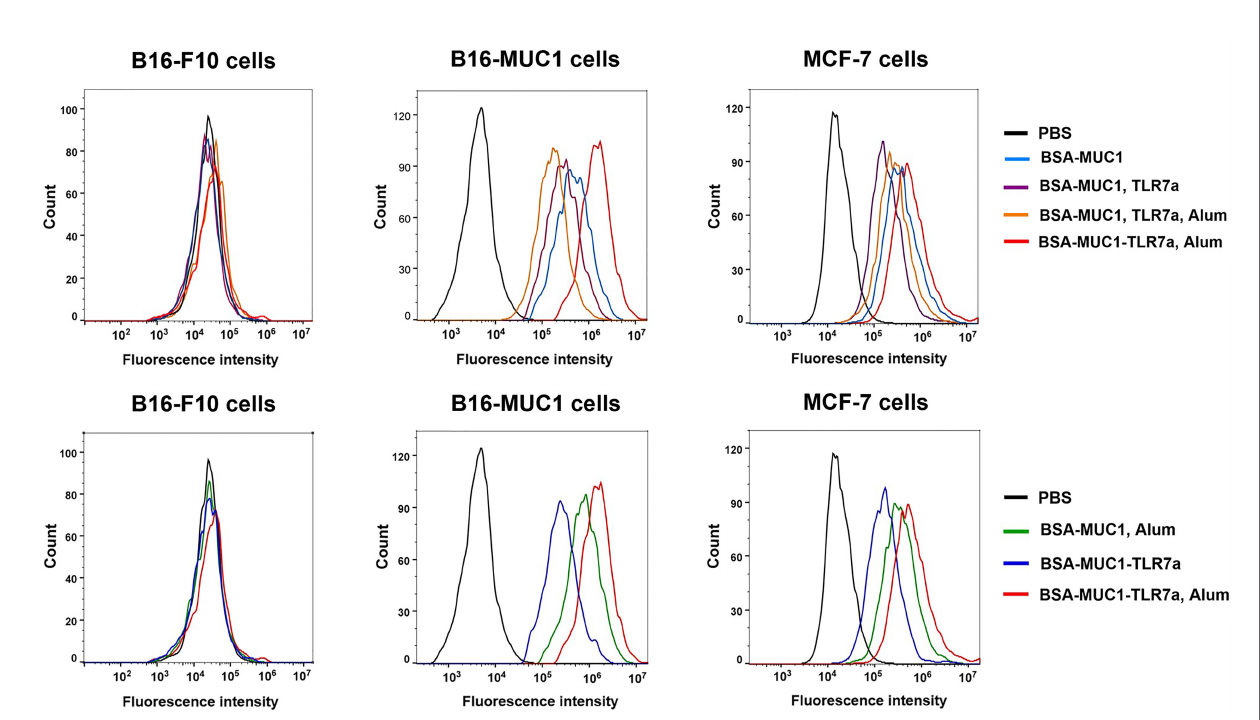
FIGURE 3 | Speci fi c antibodies recognized and bound MUC1-positive MCF-7 and B16-MUC1 cells instead of B16-F10